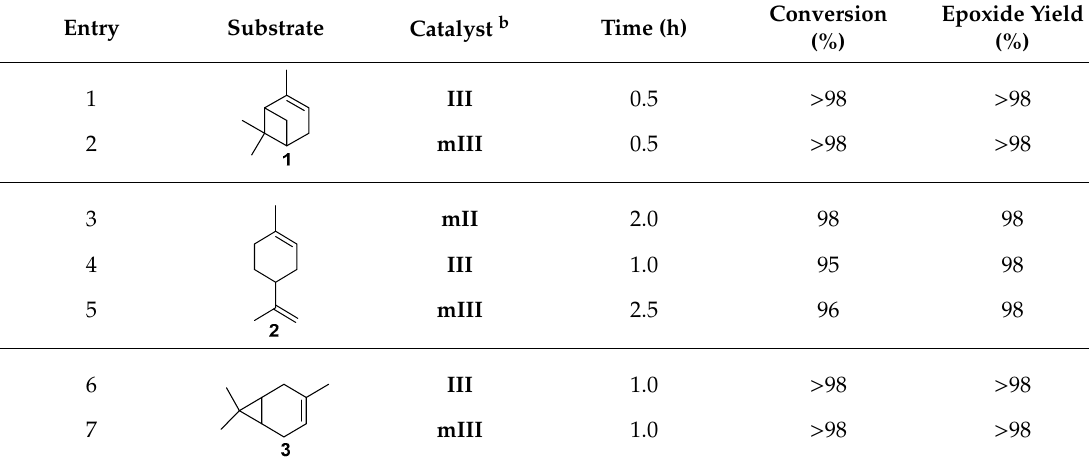
Table 5. Epoxidation of terpenic olefins by microencapsulated Lewis base of MTO a (adapted from reference [33]).